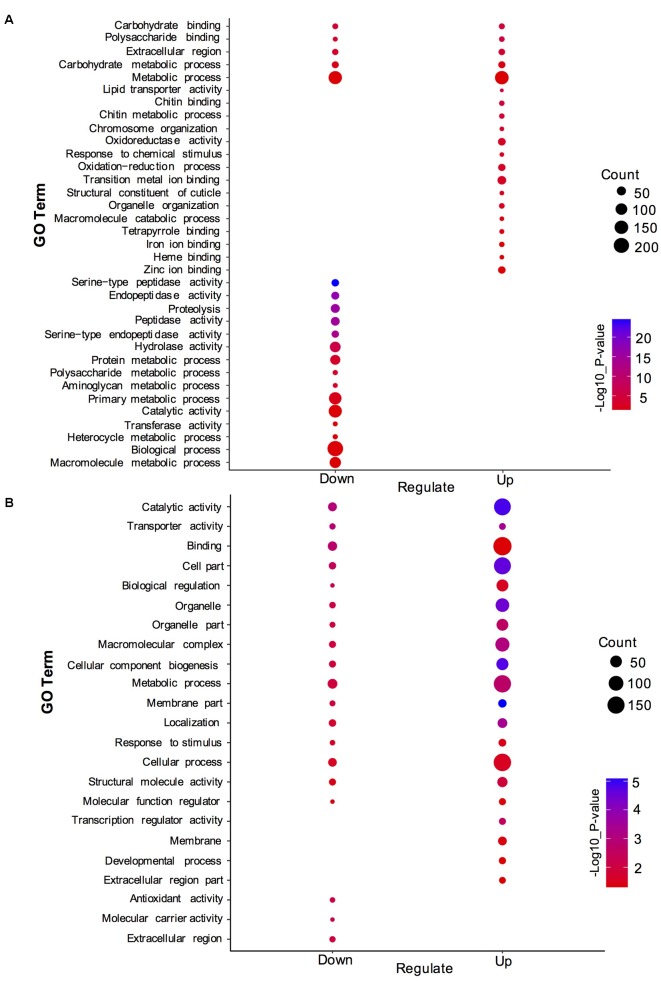
Gene ontology (GO) enrichment analysis of DEGs and DEPs in SF and PF. (A) Statistics of top 20 enriched GO terms for DEGs in SF and PF. (B) Statistics of top 20 enriched GO terms for DEPs in SF and PF. Up, up-regulated genes or proteins; Down, down-regulated gens or proteins.